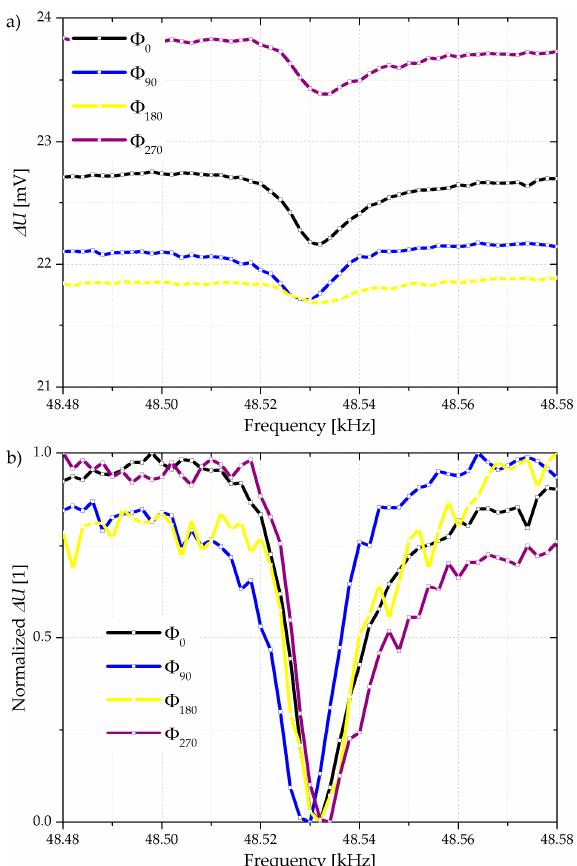
Figure 7. Selected examples of frequency-dependent Wheatstone bridge differential voltage profiles ( a ) and corresponding normalized values ( b ). The cantilever actuation phase shift varied stepwise between 0° and 270° with respect to the shaker actuation.